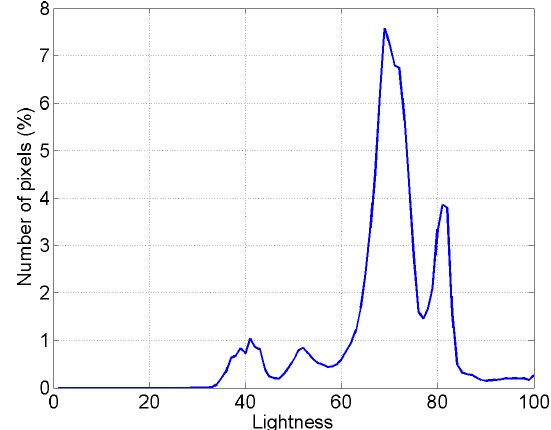
Figure 4: Example of histogram of lightness values, correspond- ing to the image in Fig.